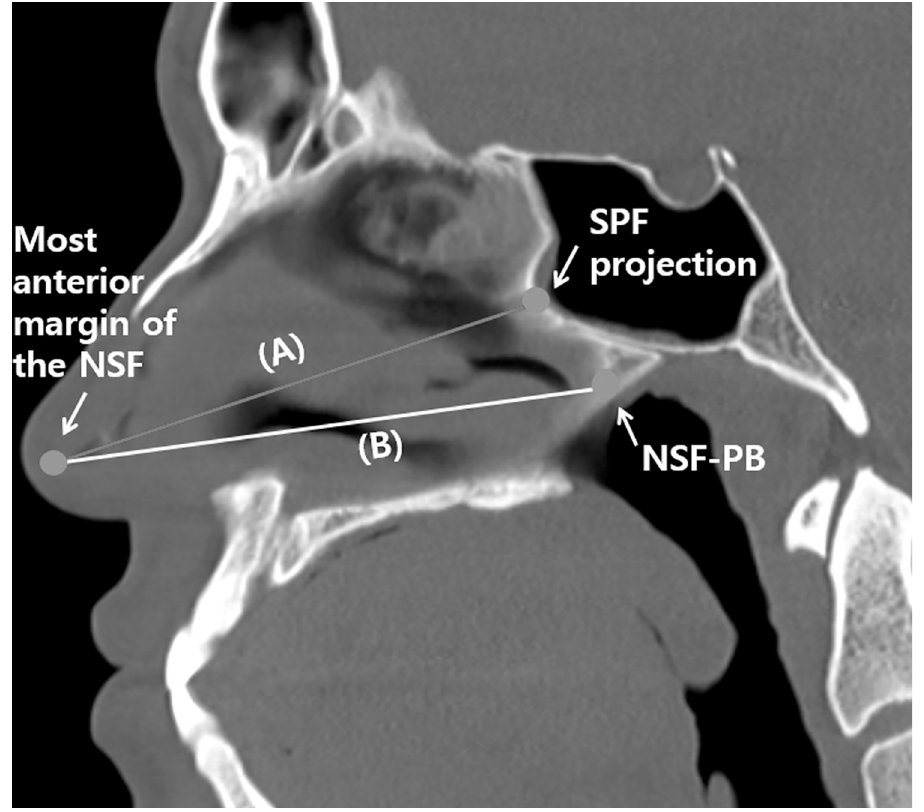
Fig 3. Measurement of the NSF length in the sagittal plane on PNS CT images. Distance from the most anterior margin of the NSF to the SPF projection (A). Distance from the most anterior to the posterior margin of the NSF (B). NSF, nasoseptal flap; SPF, sphenopalatine foramen; PB, posterior border.